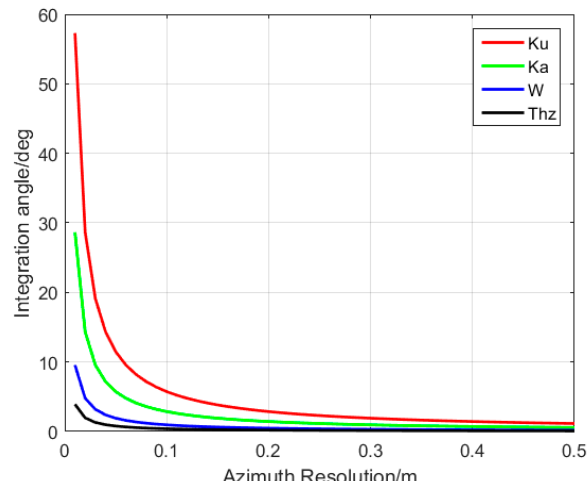
Figure 6. The relationship between azimuth integration angle and resolution. Assuming the required frame rate of ViSAR is F ps that can be written as [3,10]